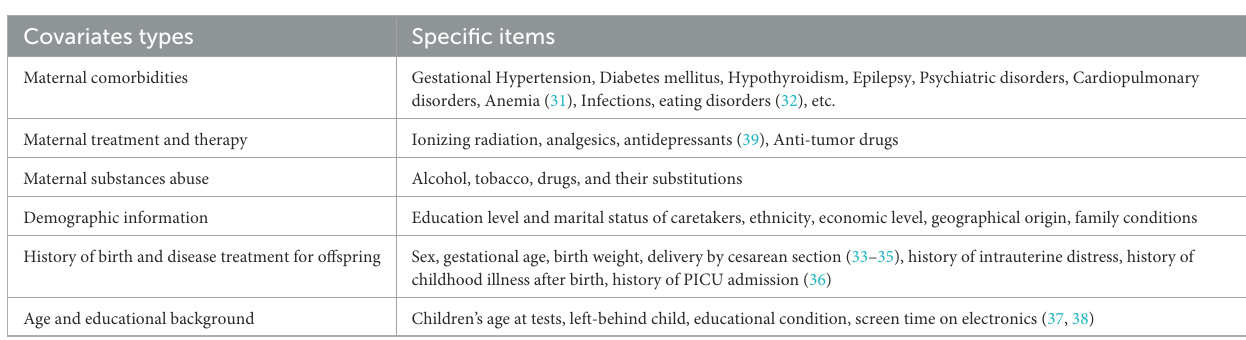
TABLE 2 Potential confounding factors of neurodevelopment in